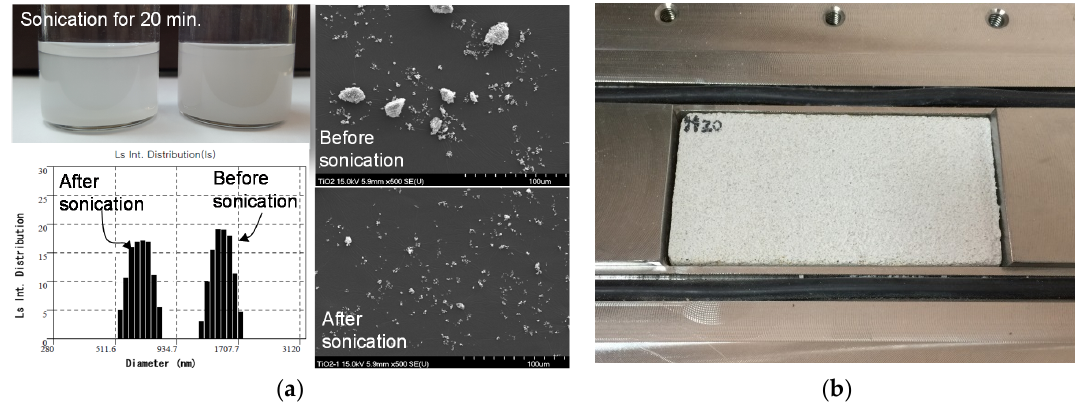
Figure 4. Specimen preparation: ( a ) sonicated aqueous TiO 2 with particle size and distribution (dynamic light scattering (DLS)) and scanning electron microscopy (SEM) data; and ( b ) the specimen in the guide table in NO test machine. Table 2. Test specimens, wt % values with respect to cement content.